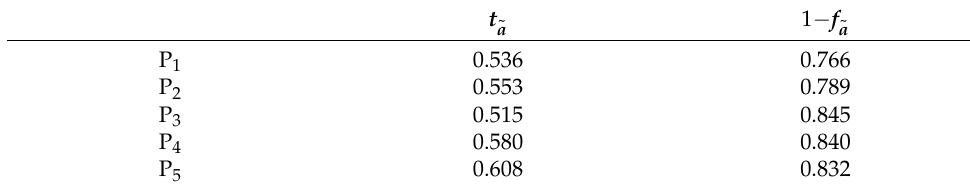
Table 20. Aggregate Vague